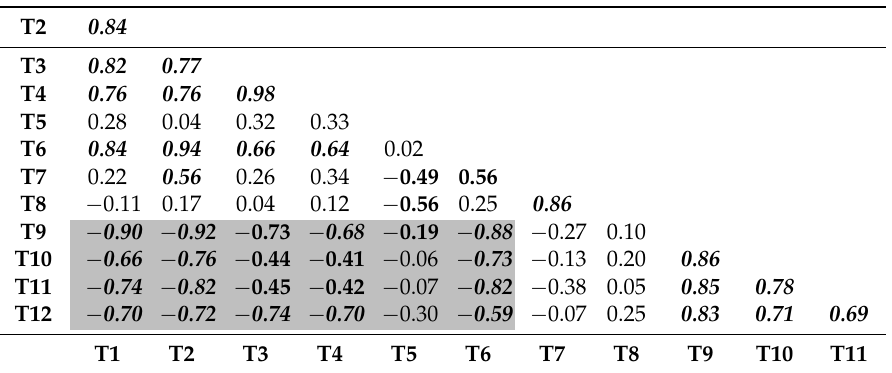
Table 4. Pearson correlation coefficients set at zero timelag compare longshore inter ‐ survey shoreline positions by transect 1941–2014. Note: bold, p < 0.05, bold italic , p < 0.01 and grey area highlights the negative relationships involved in the rotation process.